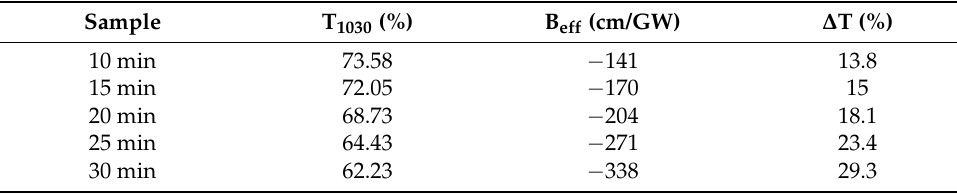
Table 1. Z-scan experimental data results.